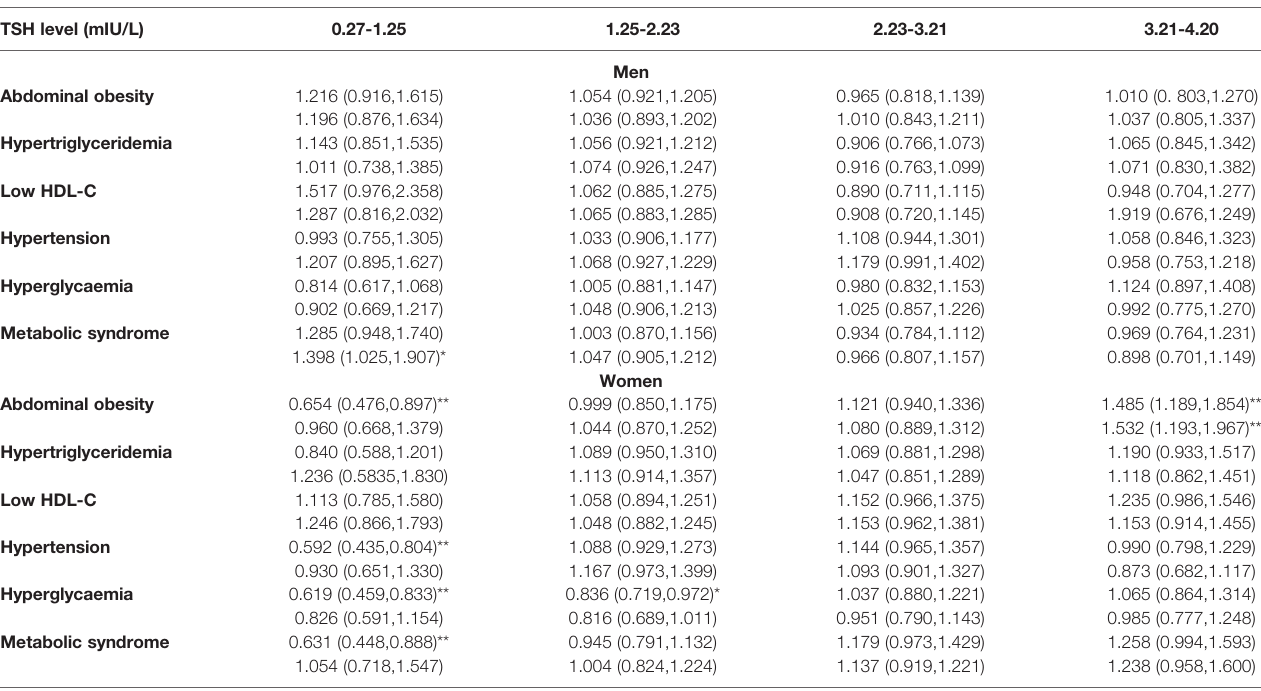
TABLE 4 | Risk of metabolic syndrome associated with TSH levels in the euthyroid group. TSH level